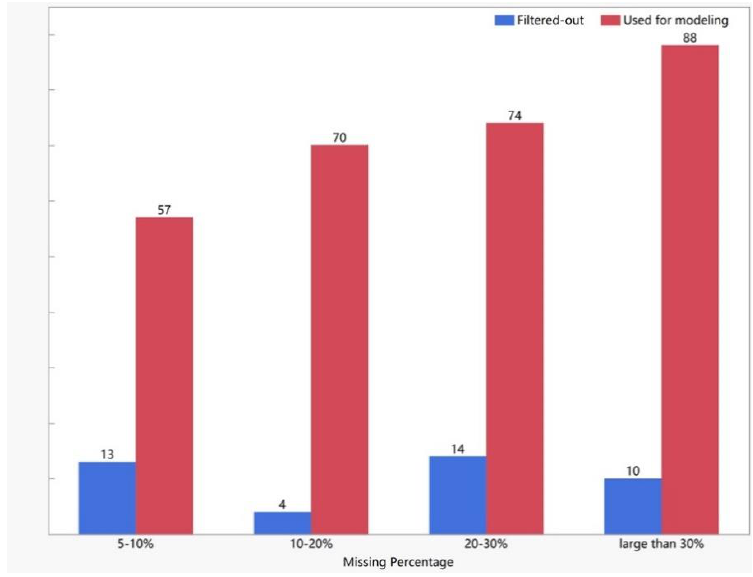
Figure 2. Number of attributes by different missing percentages.